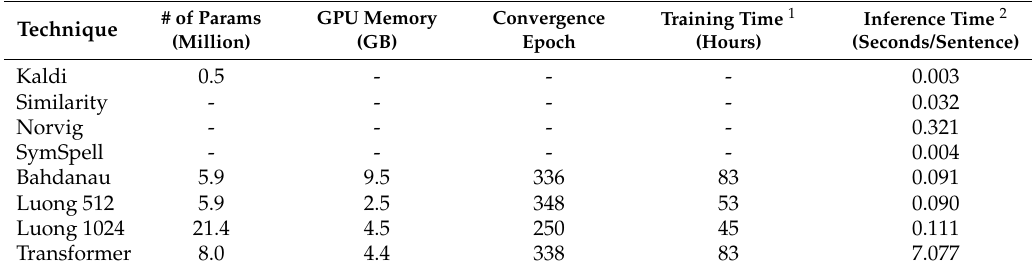
Table 8. Spelling corrector average execution